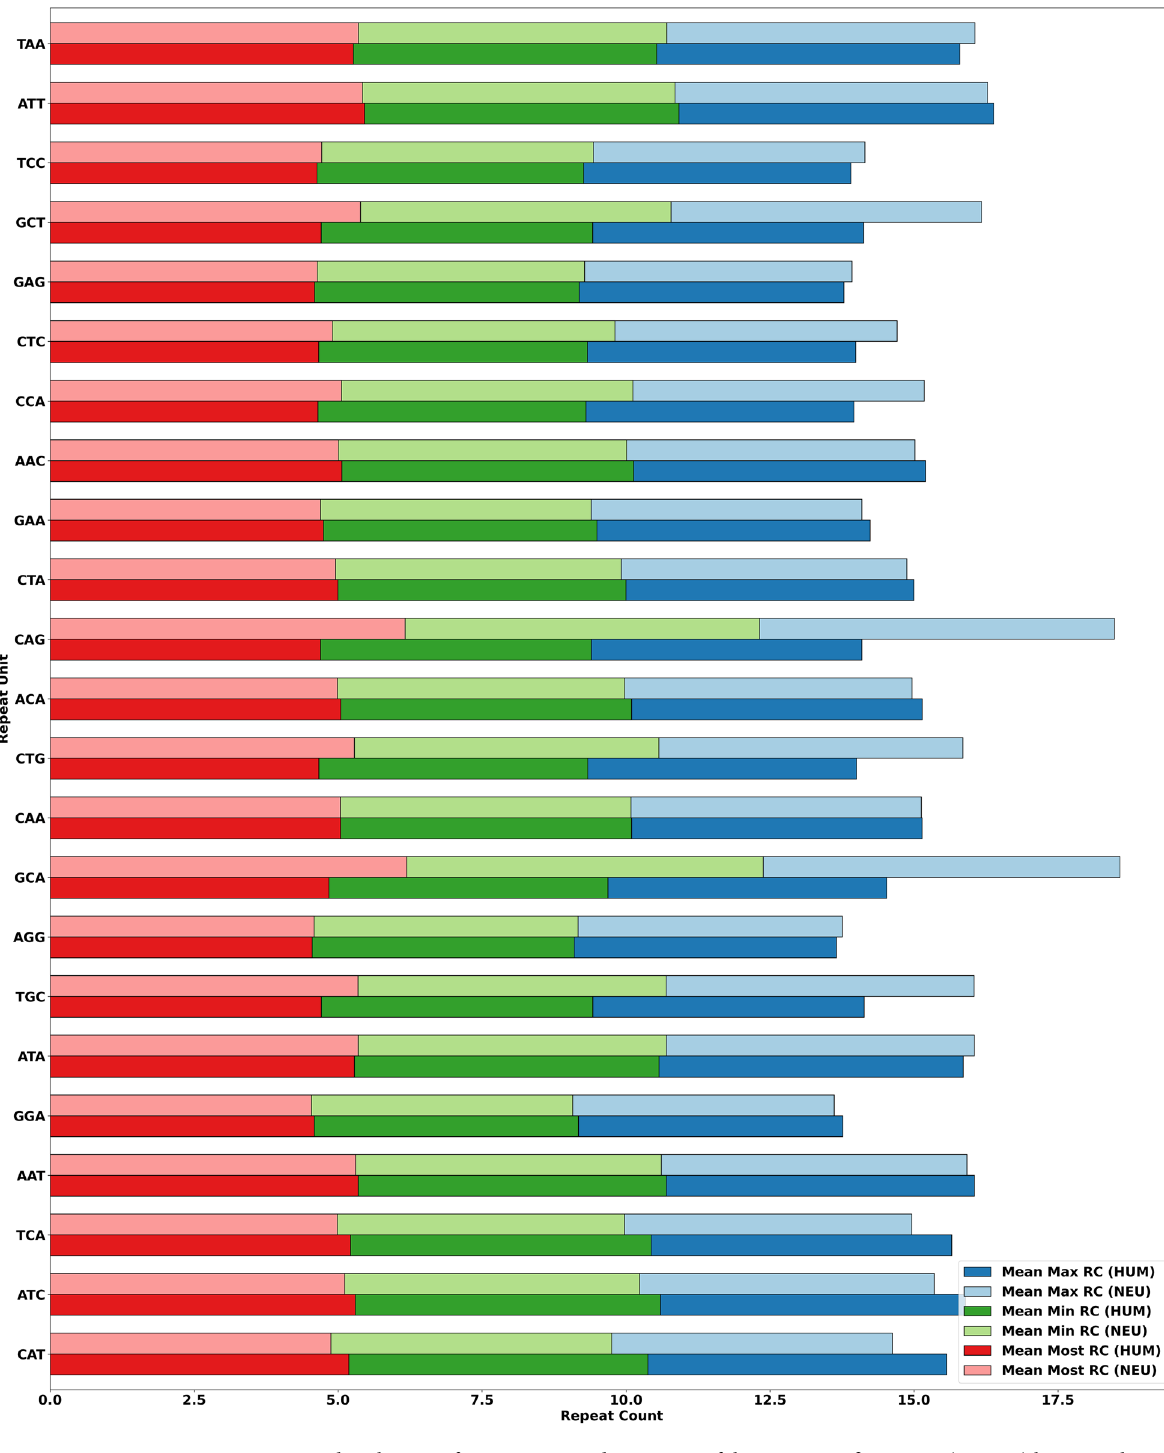
Figure 5. Mean distribution of max-, min-, and most- RC of the most significant RUs (MSRUs) between the two datasets, where MSRU CAT has the lowest adjusted p value, followed by MSRU ATC, and so